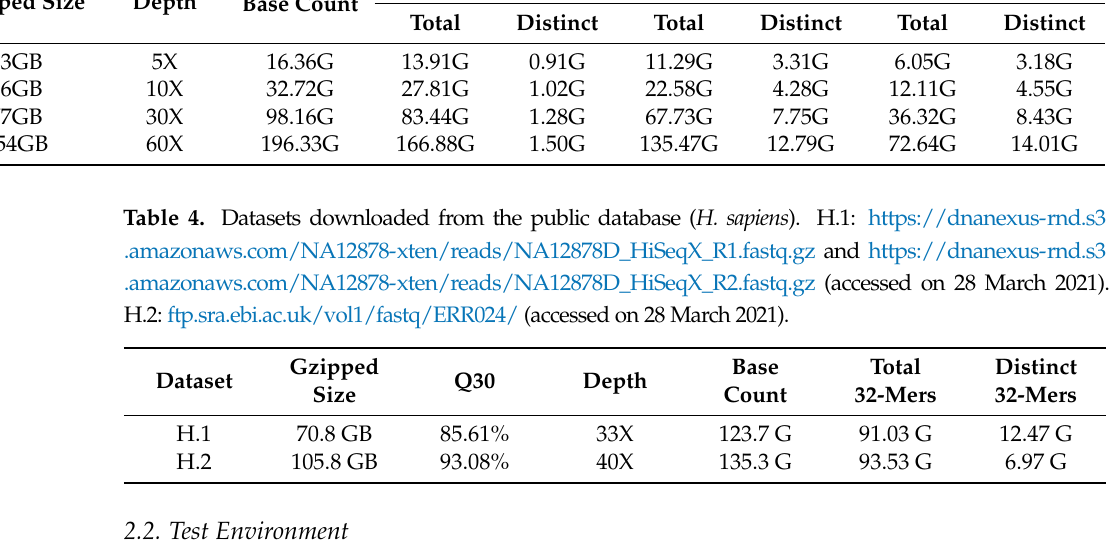
Table 3. Simulated datasets with various sequencing depths ( H. sapiens , Q30: 90.66%).